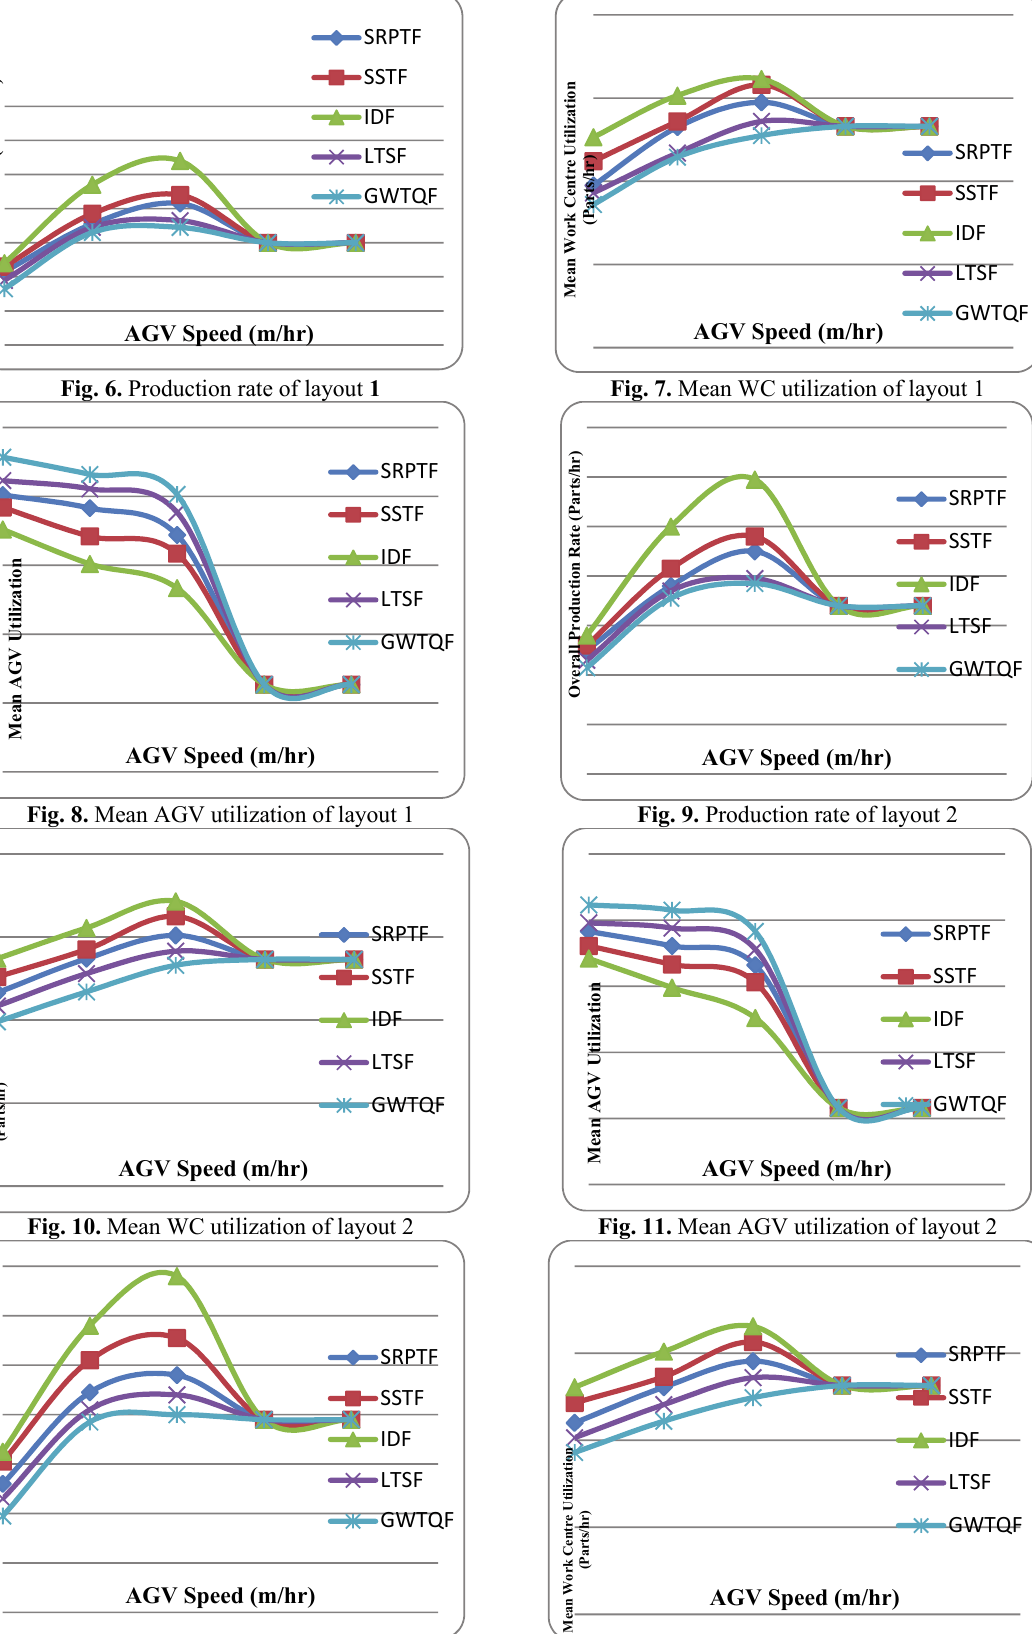
Fig. 12. Production rate of layout 3 Fig. 13. Mean WC utilization of layout